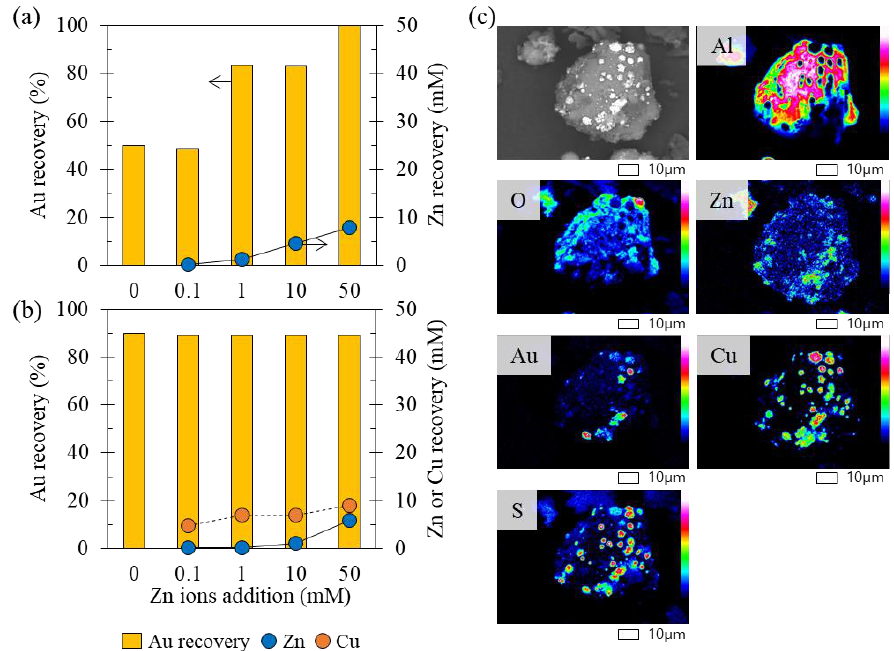
Figure 7. Recovery of gold ions from an ammonium thiosulfate solution with varying additions of Zn ion concentrations from 0 to 50 mM ( a ) without and ( b ) with 10 mM of Cu ions in the solution, and ( c ) SEM photomicrographs with corresponding elemental maps of residue.